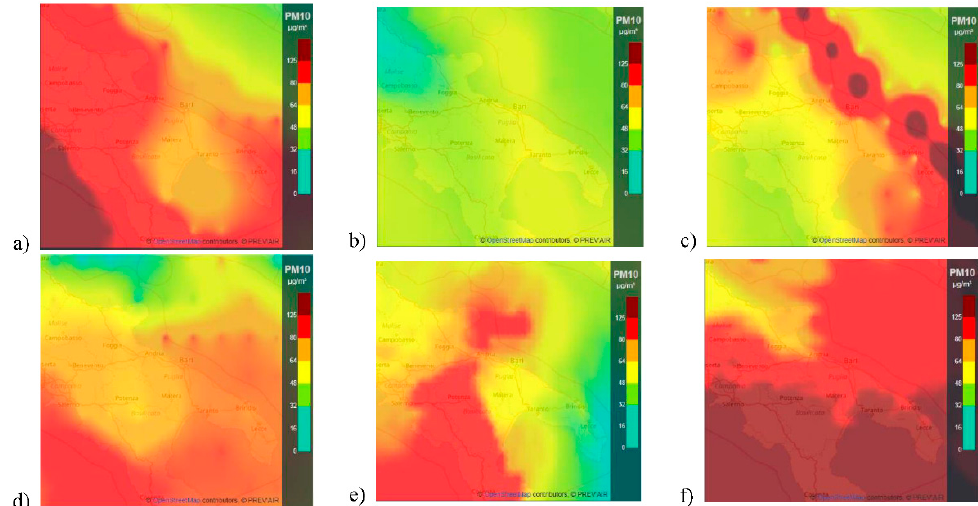
Figure 2. PM 10 daily mean ( μ g/m 3 ) simulated by PREV’AIR (www2.prevair.org) predicted in Bari: ( a )